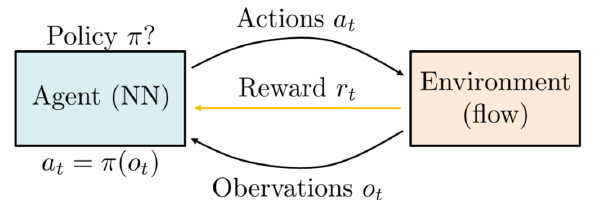
Figure 4. Schematic representation of the deep reinforcement learning process employed for flow control. The objective is to find the optimal decision policy π such that the cumulative reward is